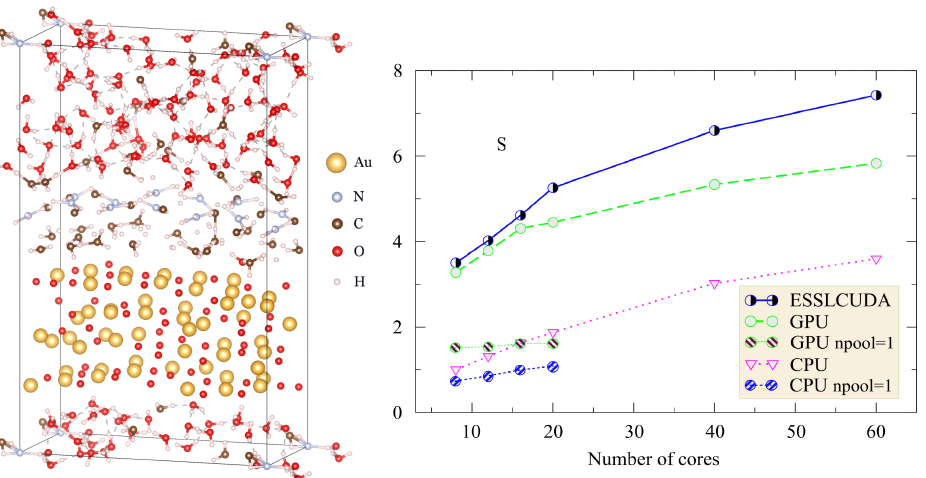
Figure 1. The orthorhombic unit cell used for simulating moistening of the gold surface coated with thiol. The second panel shows computational acceleration as a function of core number for different assemblies used for that cases calculations.